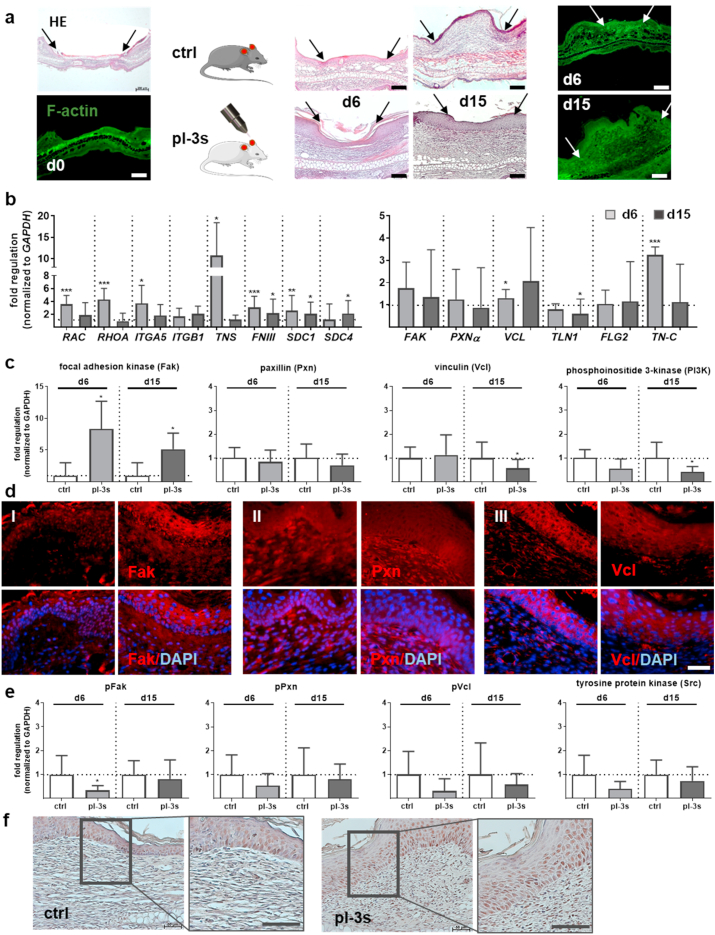
Gas plasma treatment altered the composition and assembly of adhesion sites and enhanced migratory properties during wound healing. (a) Ear wound sof SKH1 mice were either exposed to gas plasma (pl-3 s) or left untreated (ctrl) for 6 or 15 days. Representative HE staining of PFA-fixed sections showing a regular wound closure with early inflammation (d6), followed by re-epithelialization and tissue granulation in the proliferative phase (d15). FITC-phalloidin (green) was used to visualize the actin network on d0, d6, and d15, and the wound area was marked with arrows. (b) Quantitative mRNA expression analyses of RAC, RHOA, ITGA5, ITGB1, TNS, FNIII, co-receptors SDC1/4, FAK, PXNα, VCL, TLN1, and TN-C were performed. (c) Focal adhesion kinase (Fak), paxillin α (Pxnα), vinculin (Vcl), and phosphoinositide 3-kinase (PI3K) expression was quantified using WES analysis on d6 and d15. (d) Immunostaining of Fak (I), Pxnα (II), and Vcl (III) in controls (left panels) and gas plasma-treated wounds (right panels) on d6. (e) Western blot analyses of phosphorylated pFak, pPxn, pVcl, and tyrosine protein kinase (Src). (f) Phosphorylated Fak expression and its distribution were measured by pY397-FAK immunoreactivity on d15 (brown cells). Scale bars are 100 μm (a, f), 50 μm (d), 20 μm (f; right images). Data were normalized to GAPDH and untreated controls (ctrl) and presented as mean +SE. Statistical analysis was done by unpaired, two-tailed Student's t-test (n > 8) with *p < 0.05, **p < 0.01, and ***p < 0.001. (For interpretation of the references to color in this figure legend, the reader is referred to the Web version of this article.)